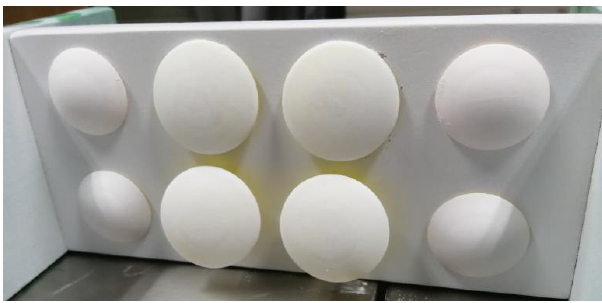
Figure 13. Tested object whose circular buckles can be manually pushed out and pulled back.